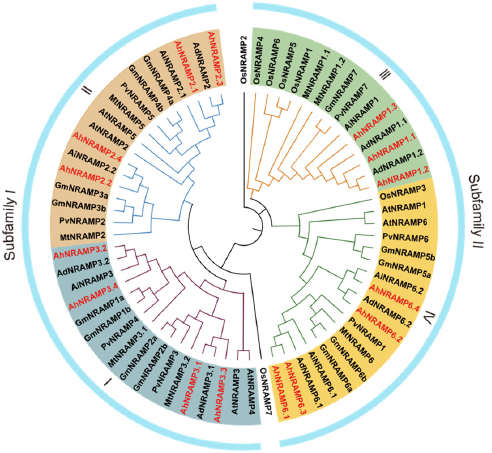
Figure 1. Phylogenetic relationships of NRAMP proteins from peanut and other plant species. The 15 AhNRAMP proteins of peanut were marked in red color. The species involved in the evolutionary tree include Arabidopsis thaliana (AtNRAMPs), Oryza sativa (OsNRAMPs), Glycine max (GmNRAMPs), A. duranensis (AdNRAMPs), A. ipaensis (AiNRAMPs), Medicago truncatula (MtNRAMPs), and Phaseolus vulgaris (PvNRAMPs). The length of AhNRAMP genes varied from 742 bp ( AhNRAMP1.2 ) to 2505 bp ( AhNRAMP6.3 ), with CDS lengths from 570 bp ( AhNRAMP1.2 ) to 1680 bp ( AhNRAMP2.2 / 2.4 ). The amino acid number of AhNRAMP proteins ranged from 190 (AhNRAMP1.2) to 560 (AhNRAMP2.2/2.4), and the molecular weight varied from 20.83 kDa (AhNRAMP1.2) to 61.39 kDa (AhNRAMP2.4). The instability, aliphatic index, and GRAVY of AhNRAMP proteins ranged from 31.17 (AhNRAMP1.2) to 42.40 (AhNRAMP2.3), from 108.53 (AhNRAMP2.2) to 124.19 (AhNRAMP3.4), and from 0.355 (AhNRAMP2.2) to 0.693 (AhNRAMP3.4), respectively. The isoelectric point (pI) of sub- family I members less than 7, while that of subfamily II members is larger than 7 (Table 1). All AhNRAMP proteins contained 12 TMDs except AhNRAMP1.2, which has only four TMDs (Table 1). The eight subfamily I proteins were predicted to localize in the vacuole membrane, whereas the seven subfamily II proteins localized to the plasma membrane (Table 1). 2.2. Conserved Motifs, Domains, and Models of AhNRAMP Proteins A total of ten conserved motifs were identified in the sequences of AhNRAMP pro- teins, and all of them were annotated to be NRAMP according to the Pfam tool (Figure 2A and Table S1). As shown in Figure 2A, all AhNRAMP proteins contain nine motifs except AhNRAMP1.2. The members of the same subfamily shared the same motif composition; however, considerable differences were also observed between the two subfamilies. Sub- family I members specifically contained motif 7, while subfamily II specifically contained motif 10. All AhNRAMP proteins shared motifs 1, 2, 3, 4, 5, 6, 8, and 9 except AhNRAMP1.2, which only contains the last two motifs of AhNRAMPs, indicating a dis- tinct evolutionary process and physiological function. All AhNRAMP proteins contained one domain named NRAMP, which is the typical domain of the NRAMP family (Figure 2B).